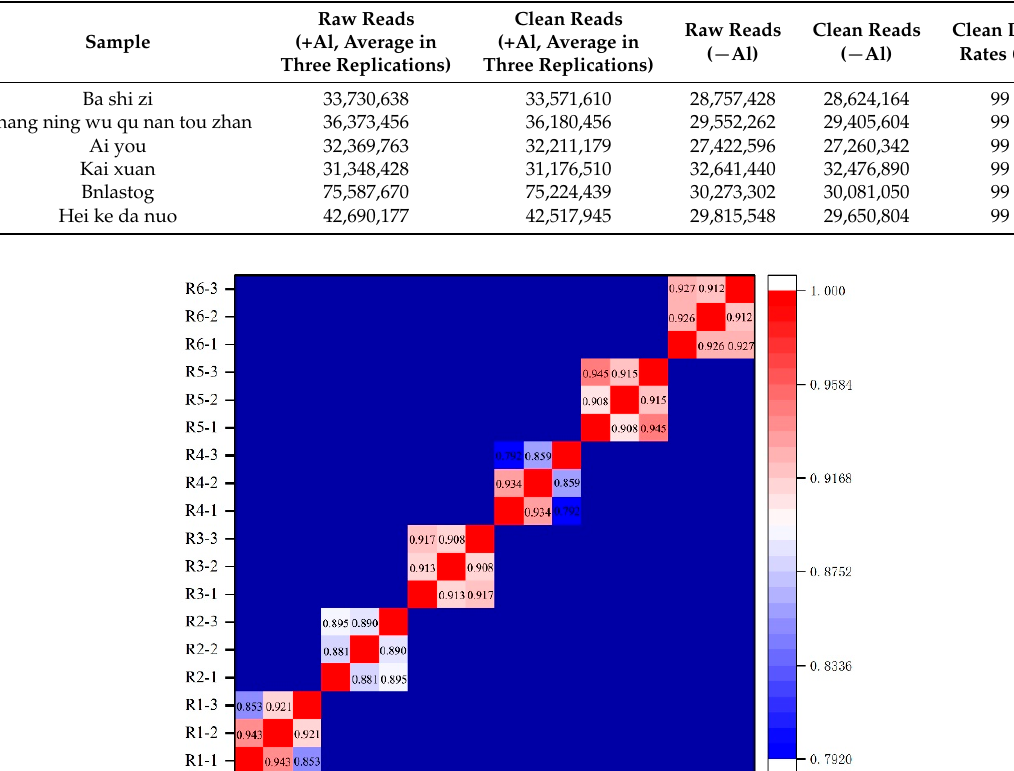
Figure 1. Relative root elongation (RRE) of six varieties in this study. Table 1. Summary of RNA sequencing.